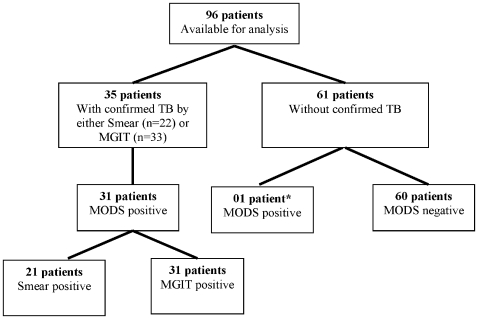
MODS positive in relation to Smear and MGIT, by patient.* This patient was deemed a false positive due to H37Rv (the positive control strain) identification by spoligotyping.